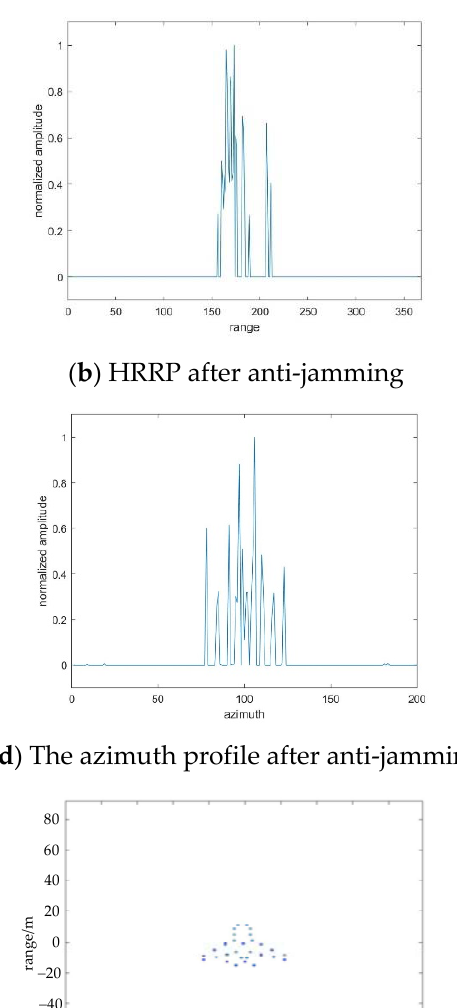
  ， M 29 8 . In Figure 7e, multiple d